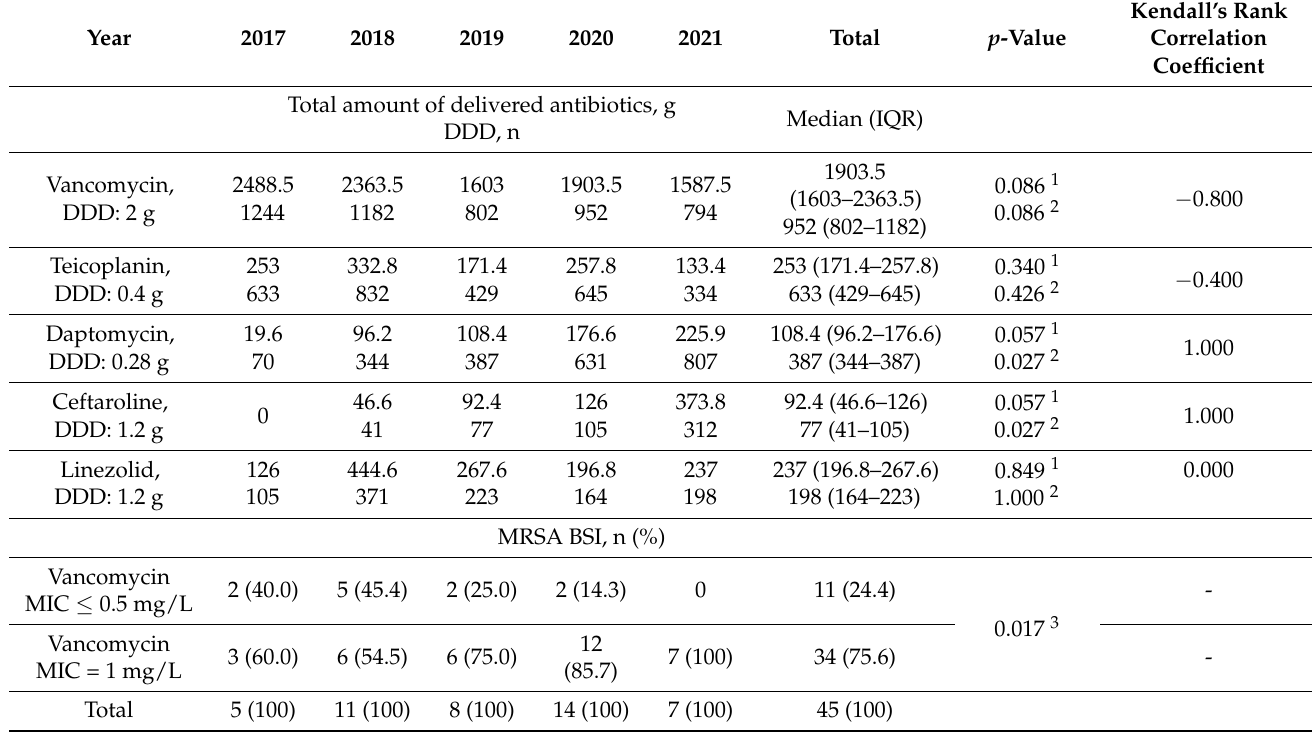
Table 1. Distribution of the antibiotic consumption and of the MRSA BSIs over the 5-year period.